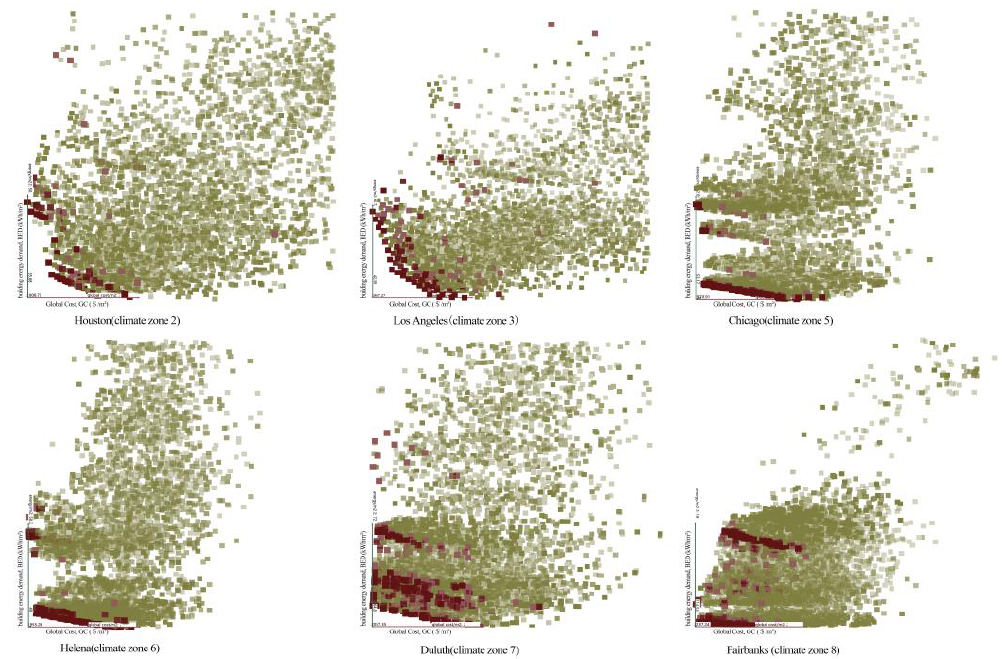
Figure 15. Building energy demand (BED, vertical axis) and global cost (GC, horizontal axis) Pareto frontier in typical American cities.